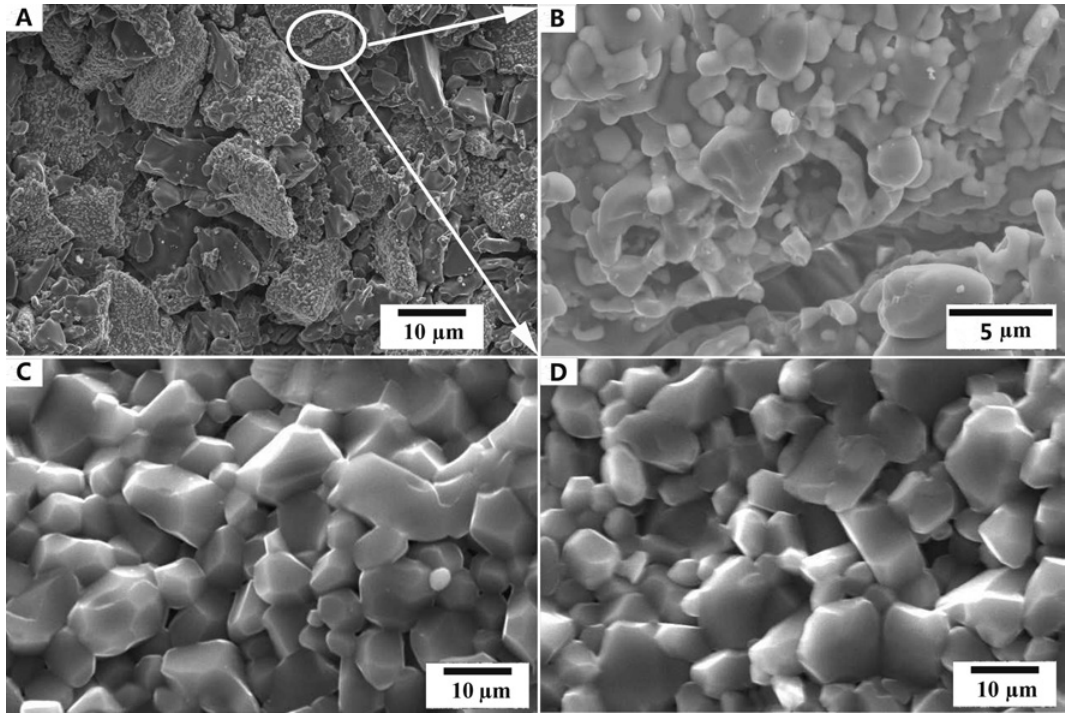
In order to further evaluate the thermal shock resist- ance behavior, the microstructures of samples Z Z after thermal shock tests are examined, as shown in 3 Figure 9. Some microcracks are observed on the surfaces of all the samples due to the spontaneous transforma- tion of ZrO , which can relax the stress concentration to 2 enhance the thermal shock resistance of Al addition, for the sample with 3Y-ZrO prevent crack propagation by compressive stress due